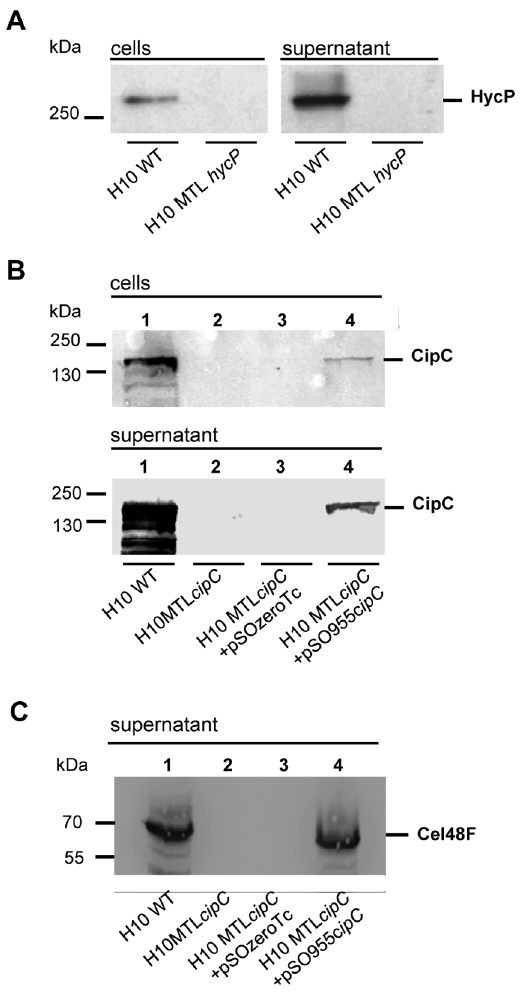
Figure 4. Detection of HycP CipC and Cel48F in different Clostridiumcellulolyticum strains. Different C. cellulolyticum strains were studied: wild-type strain, MTL hycP , MTL cipC , MTL cipC (pSOS955- cipC ) and MTL cipC (pSOSzero-Tc) strains. Aliquot was taken from a culture of these strains at the exponential growth phase on cellobiose substrate, and centrifuged to separate the cells and the supernatant. Cell fraction and 10% TCA precipitated supernatant fraction corre- sponding to the same culture volume were subjected to SDS-PAGE. After transfer onto nitrocellulose membranes, membranes were probed with antibodies directed against HYR modules from HycP (Panel A), or CipC (Panel B), or Cel48F (Panel C).